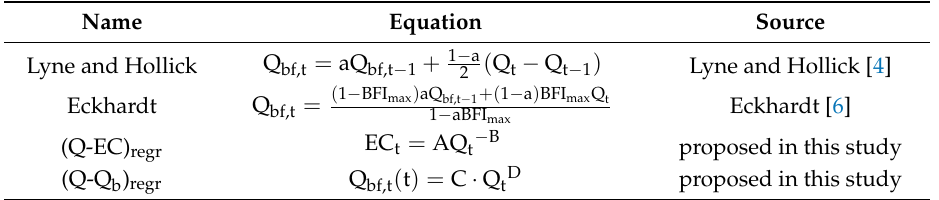
Table 1. Baseflow separation methods used in the current